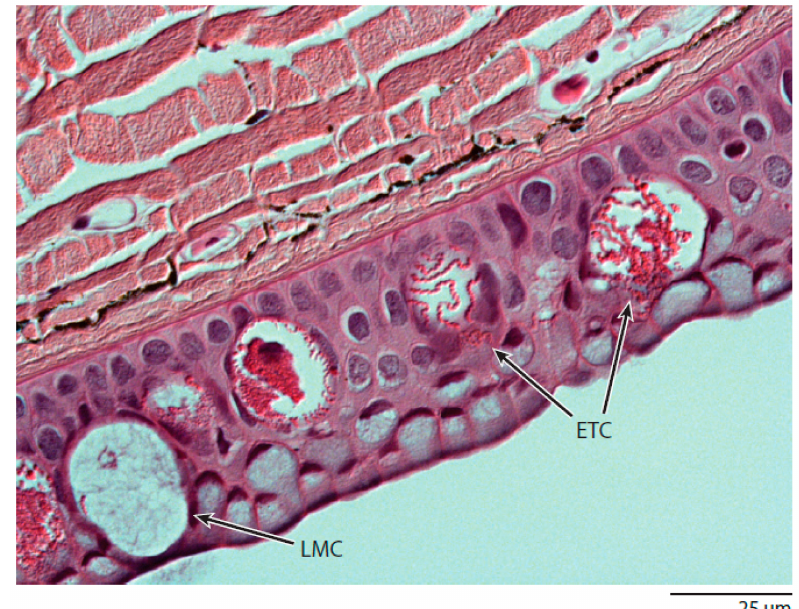
Figure 8. Histological cross-section through hagfish skin. Within the hagfish epidermis are two large secretory cell types, large mucus cells (LMCs) and epidermal thread cells (ETCs). These two epidermal cell types share similarities with the two main secretory cell types within slime glands, gland mucus cells (GMCs) and gland thread cells (GTCs). Both LMCs and GMCs are packed with mucin vesicles, while ETCs and GTCs both produce a coiled proteinaceous thread in their cytoplasm [55].